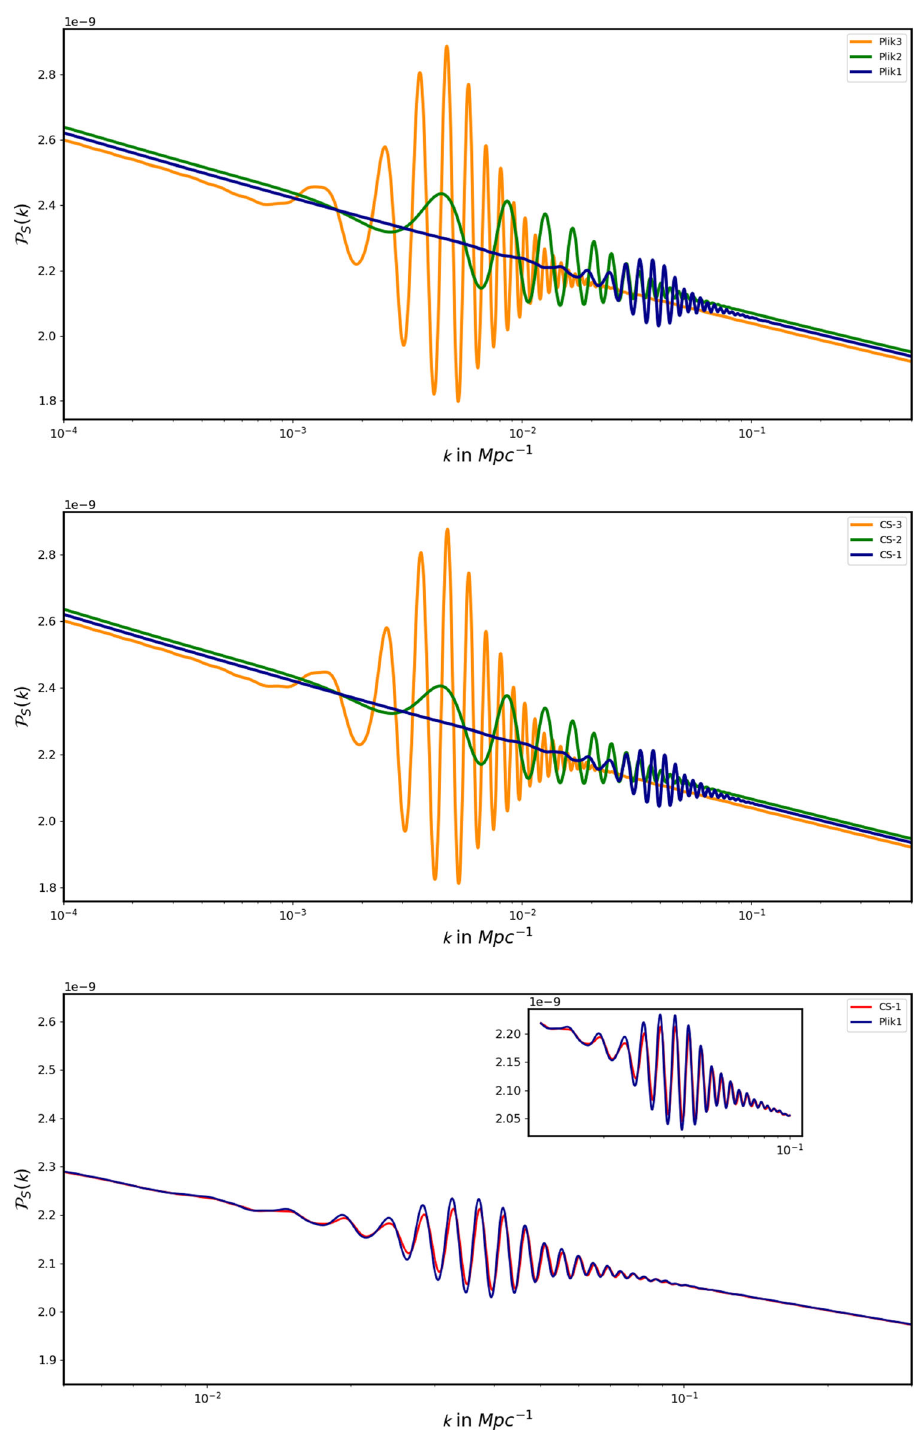
Fig. 6 Power-spectrum for the best-fit candidates to the Plik-bin1 likelihood Plik-1, Plik-2 and Plik-3